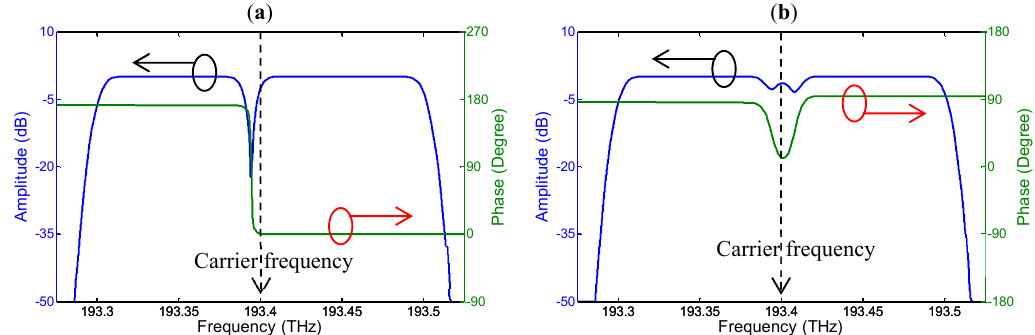
Figure 11. The amplitude and phase response profile of the LCOS based optical processor designed for the 90° hybrid coupler ( a ) I-phase channel and ( b ) Q-phase channel.